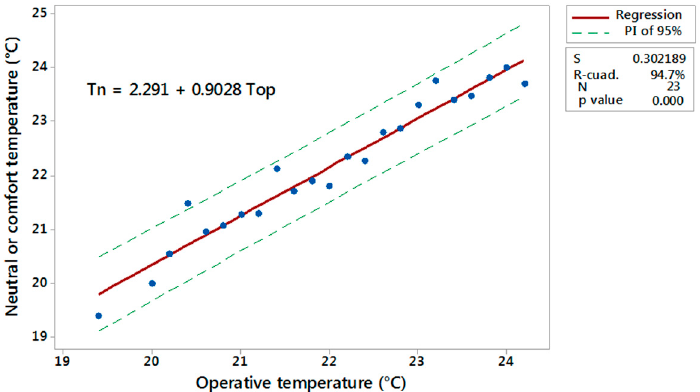
Figure 11. Variation of comfort or neutral temperature with the mean operative temperature. Recorded operative temperatures were grouped in bins of 0.2 °C. The neutral temperatures were obtained from the Griffiths’ equation, using a Griffiths’ constant of 0.5. The binned operative temperatures and their corresponding comfort votes from surveys were used to calculate the neutral temperatures.